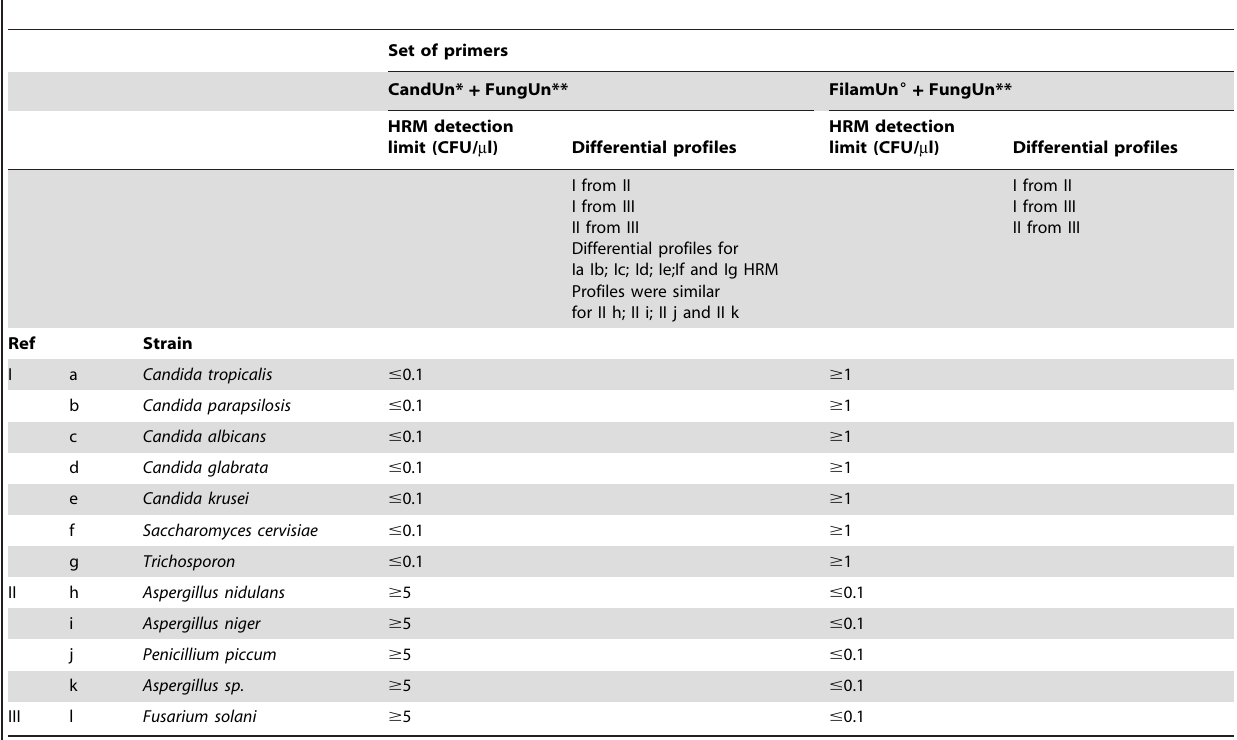
Table 1. High-resolution melting analysis (PCR-HRM) detection limits (fungal spore suspensions titrated by plating) and discrimination among fungal species using the primers CandUn + FungUn and FilamUn +